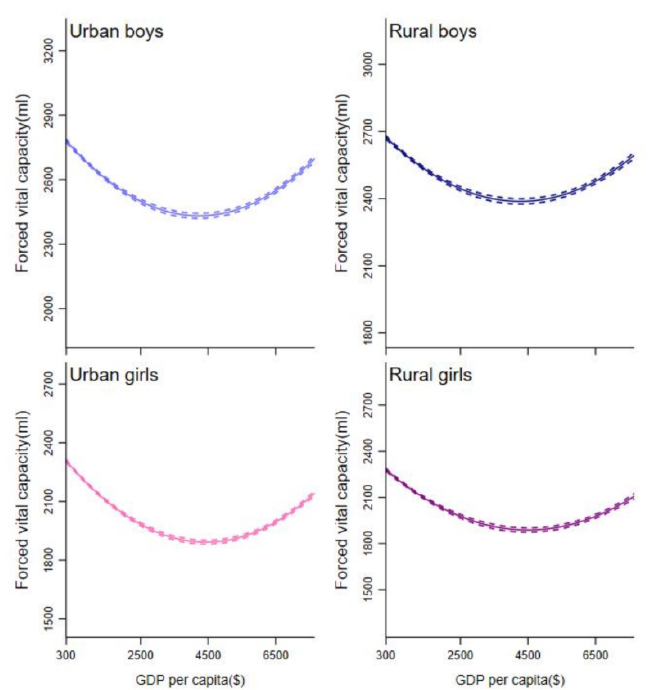
Figure 2. Association between per capital GDP and lung function from 1985 to 2014. Separate models were fitted for lung function by adjusting for age, height, weight, time trends and other time-invariant characteristics. Dotted lines indicate 95% CIs. GDP = gross domestic product.